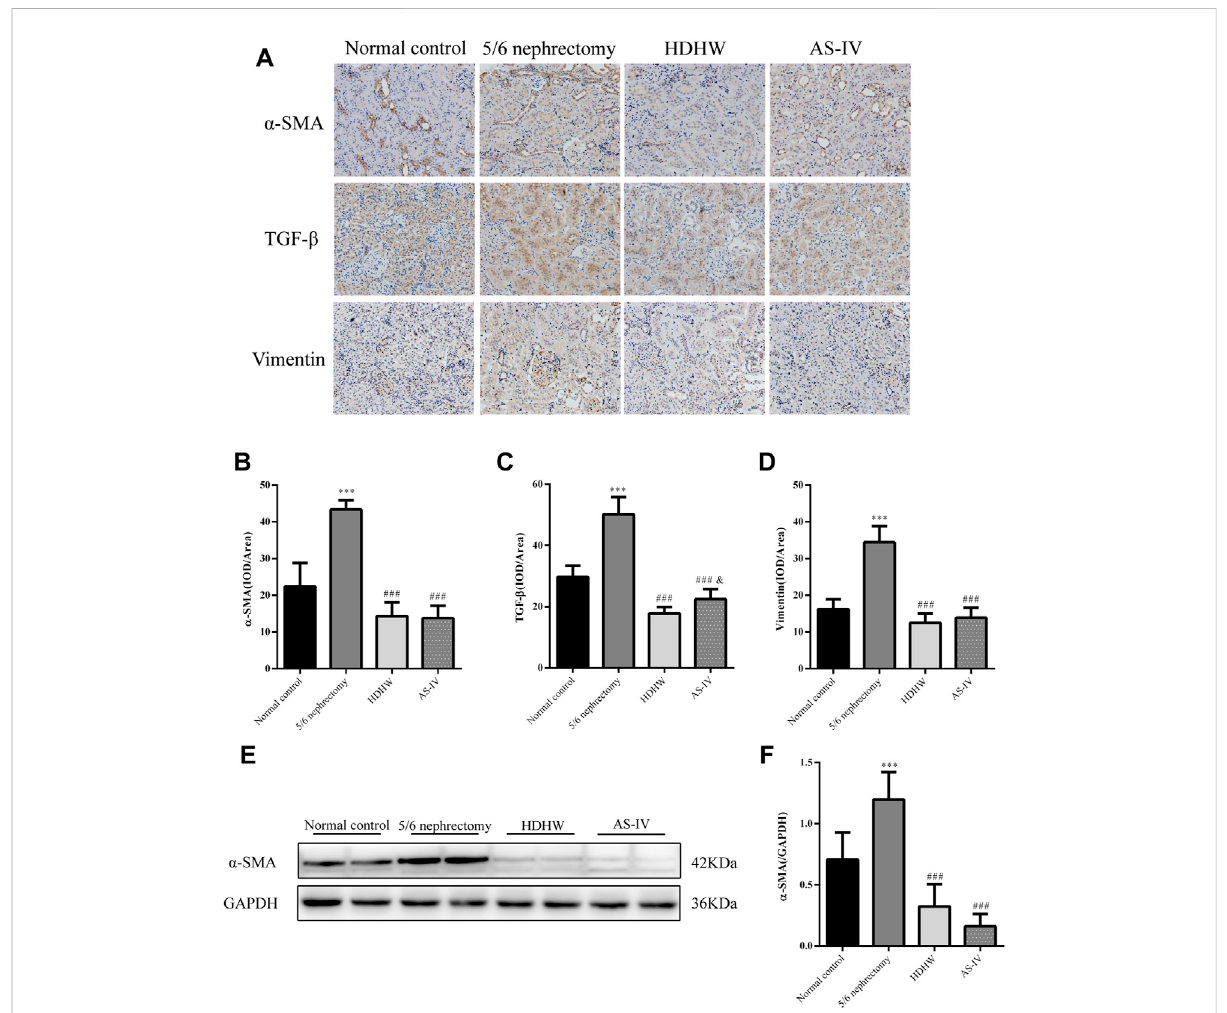
FIGURE 3 HeidihuangWan(HDHW)ameliorates renal fi brosis. (A) Immunohistochemicalstainingwas usedto analyze theexpression of α -smoothmuscle actin ( α -SMA), transforming growth factor- β (TGF- β ), and Vimentin. (B,C,D) Image-Pro Plus software was used to statistically analyze the immunohistochemical staining results of α -SMA, TGF- β , and Vimentin, respectively. (E) Western Blotting to detect the protein level of α -SMA. (F) Protein concentration analysis. Data arepresented asmean ±SD, n =6. Thedata areexpressedas *** p < 0.001: compared with normal control group; ### p < 0.001: compared with 5/6 nephrectomy group; & p < 0.05: compared with HDHW group,